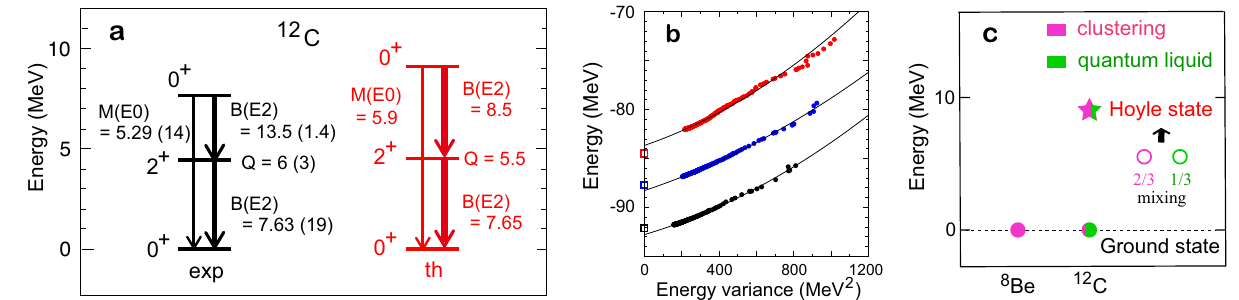
and 0 þ (Hoyle state) energy levels, and the B ( E 2) ( M ( E 0)) values in the unit of e 2 fm 4 (e fm 2 ) compared to Fig. 5 Properties of 12 C nucleus. a The 2 þ 1 2 experiments 20,46 . Data are also from the National Nuclear Data Center ’ s `Evaluated Nuclear Structure Data File ’ (http://www.nndc.bnl.gov/ensdf/). (black), 2 þ (blue), and 0 þ (red) states against the energy variance. Open squares indicate experimental values. Solid lines b Energy eigenvalues of the 0 þ 1 1 2 imply polynomial extrapolation. c Schematic illustration for the Hoyle state (star), comprising clustering (pink), and quantum – liquid (green) components (open circles). Ground-state properties are depicted for 8 Be and 12 C.